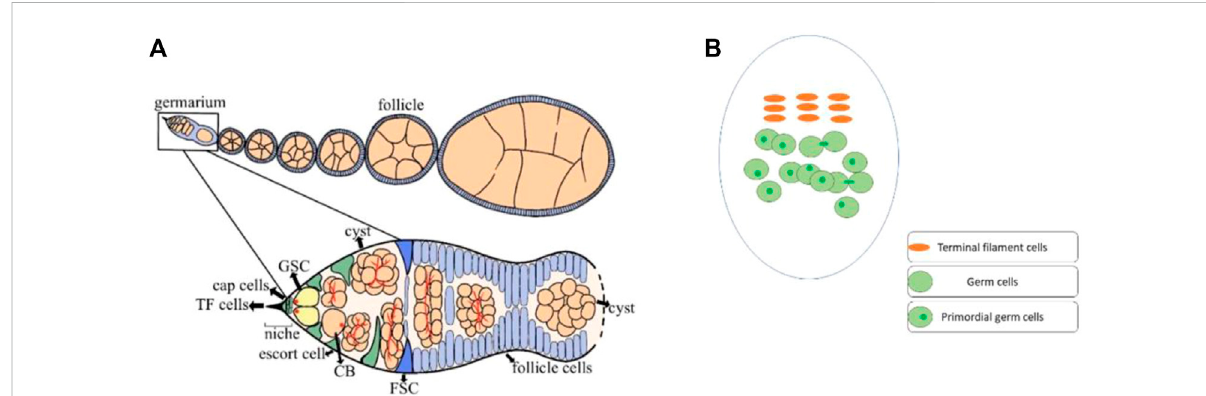
FIGURE 1 Ovaries of Drosophila house different types of cells. (A) The adult ovary of Drosophila consists of 16 – 20 ovarioles, and the germarium of each ovariolehasdifferenttypesofcells.Thegermlinestemcells(GSCs)strictlymaintainanddifferentiateundertheregulationofsignalsfromthesomatic cells. At every stage of early cell division, the GSCs are surrounded by somatic cells for their proper regulation. GSCs divide into cystoblasts (CBs), whichlaterundergo fourroundsofmitoticdivisiontogeneratea16-cells cyst.Intheend,onlyonecell amongthese16-cellcystsdifferentiates as an oocyte. (B) The third instar larval ovary of Drosophila , also consists of somatic cells and germ cells. Before pupation, most of the terminal fi laments (TF) cells has formed. While the TF cells completely formed at the early pupal stage. The germ cells can be identi fi ed with a germ cell- speci fi c marker (anti-vasa). However, only the germ cells with single dot-shaped spectrosome were considered as